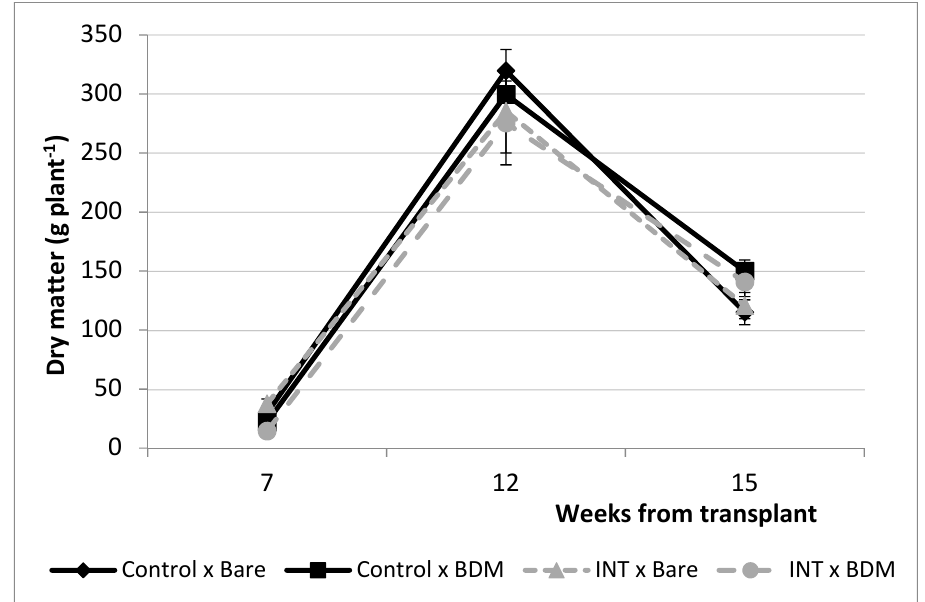
Figure 4. Dry matter accumulation in fruits biomass of tomato cv Kendras during the 2018 crop cycle. Legend: vertical bars represent error standard of mean (N = 10) per each combination of treatments in different sampling times. Control × Bare: standard farm fertilization × Bare soil; Control × BDM: standard farm fertilization × Biodegradable mulch; INT × Bare: solid digestate integrated with mineral fertilizers × Bare soil; INT × BDM: solid digestate integrated with mineral fertilizers × Biodegradable mulch.